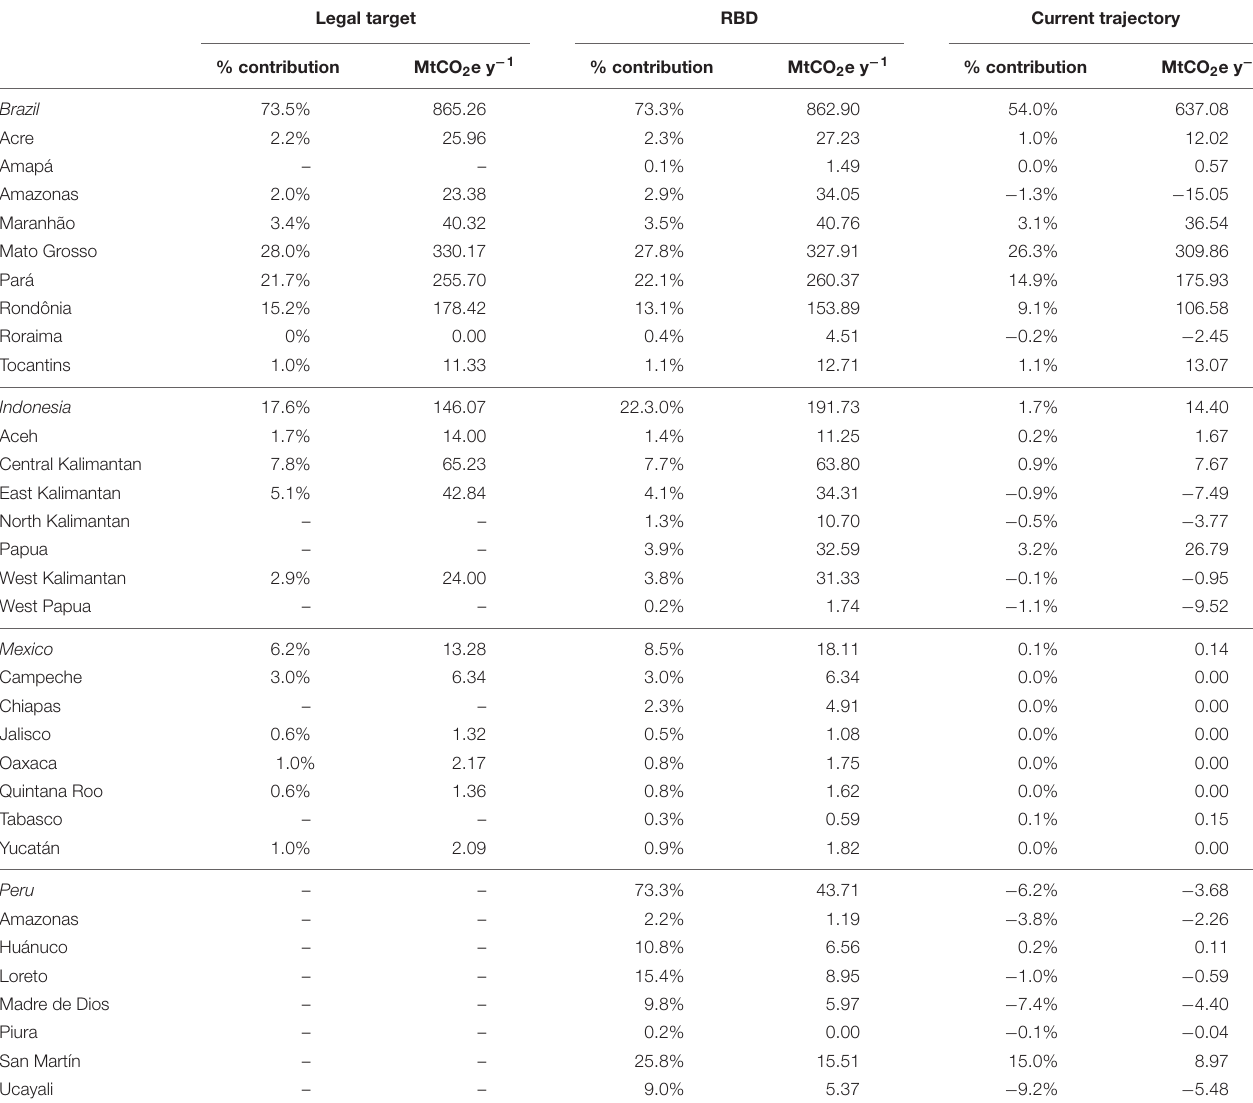
TABLE 6 | Percent of respective national NDC emissions reduction goal contributed by each jurisdiction under three alternative scenarios: (i) full compliance with legal deforestation reduction target, (ii) full compliance with RBD deforestation reduction target, and (iii) continuation of current deforestation trajectory. Legal target RBD Current